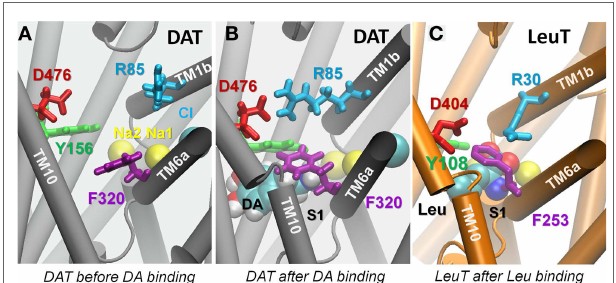
Figure 5 | Dopamine binding to site s1 prompts the closure of ec gate and dopamine-bound hDaT resembles leu-bound leuT . (a) Substrate binding pocket before dopamine binding, typical of the outward-facing open conformation; (B) same pocket after dopamine (vDW format) binding. Isomerization of F320 (purple) brings its aromatic side chain on top of dopamine. Close association of Y156-F320 and salt bridging of R85-D476 designate the closure of the EC gates, indicating hDAT in its outward-facing closed state; and (c) crystal structure of LeuT with Leu bound to the S1 site (PDB: 2A65), in which the homologous EC gate residues orient in a similar pose to that shown in (B) . Snapshot in (B) is taken from 100 ns in run